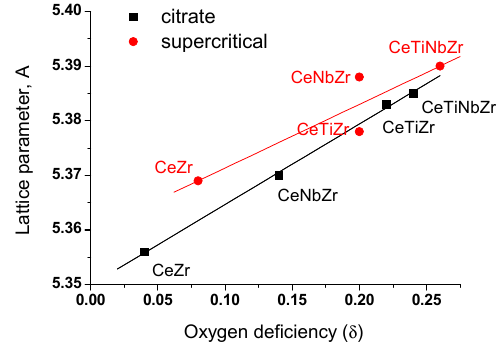
Figure 4. Dependence of the lattice parameter on the oxygen deficiency.